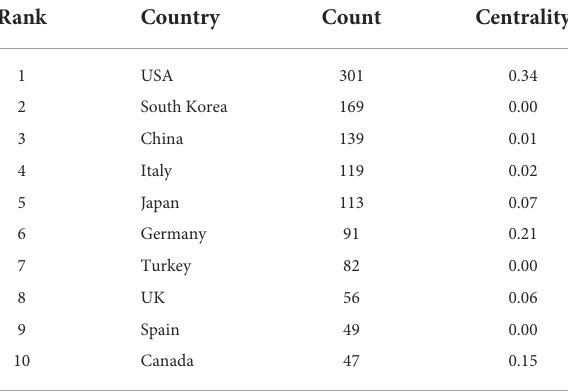
TABLE 1 The top-10 countries with the most publications in the field of